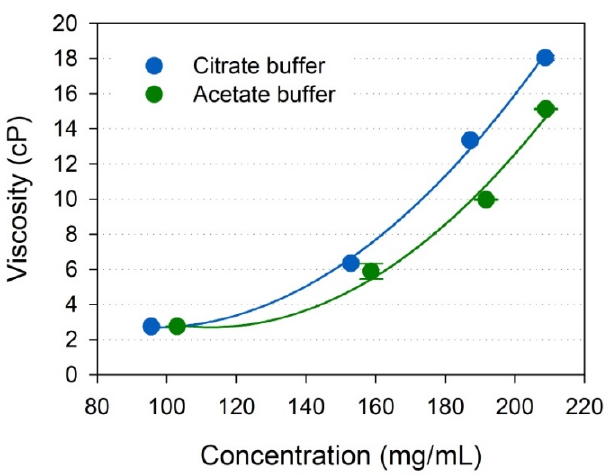
Figure 6. Viscosity profiles of IgG solutions from 95 mg/mL to over 209 mg/mL in acetate buffer (green) and citrate buffer (blue) at the same pH 4.6. Values are the mean and standard deviation from triplicate measurements.